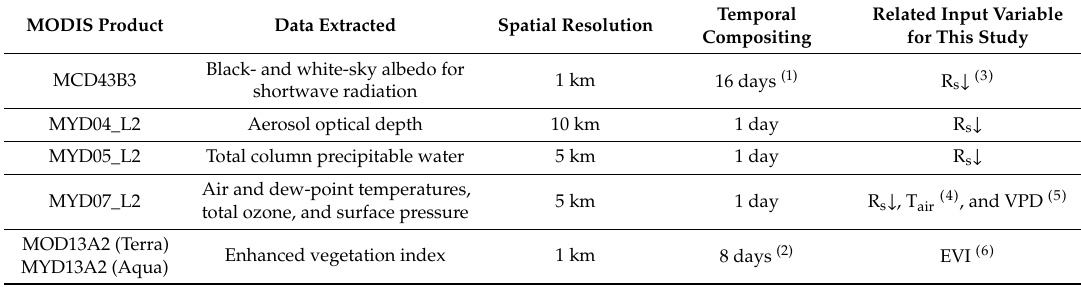
Table 1. Moderate-resolution Imaging Spectroradiometer (MODIS) products used in the calculation of input data for the estimation of daily gross primary productivity (GPP) in the forest of South Korea. Temporal Related Input Variable MODIS Product Data Extracted Spatial Resolution Compositing for This Study Black- and white-sky albedo for MCD43B3 1 km 16 days (1) R s ↓ (3) shortwave radiation MYD04_L2 Aerosol optical depth 10 km 1 day R s ↓ MYD05_L2 Total column precipitable water 5 km 1 day R s ↓ Air and dew-point temperatures, MYD07_L2 5 km 1 day R s ↓ , T air (4) , and VPD (5) total ozone, and surface pressure MOD13A2 (Terra) Enhanced vegetation index 1 km 8 days (2) EVI MYD13A2 (Aqua)